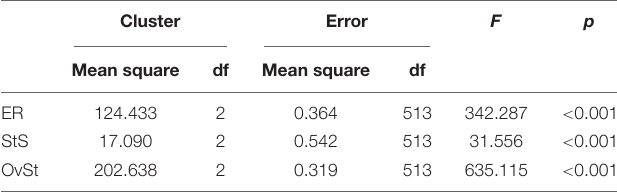
TABLE 2 | K-Means cluster groups with ANOVA results for the three subscales of HSPS. Cluster Error F p